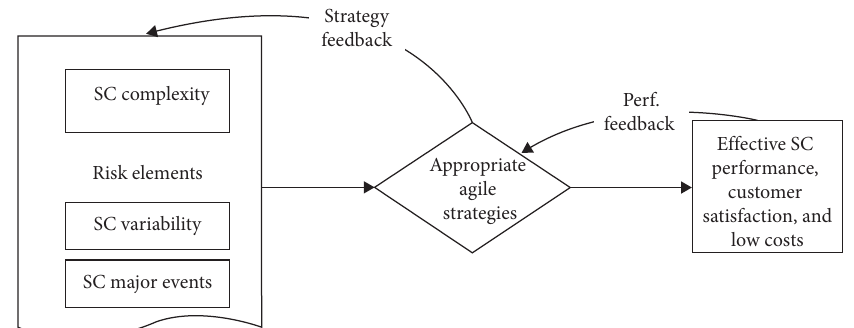
Figure 1: Modeling for SC risk algorithm. Source: accepted by Monroe and Martin, 2008